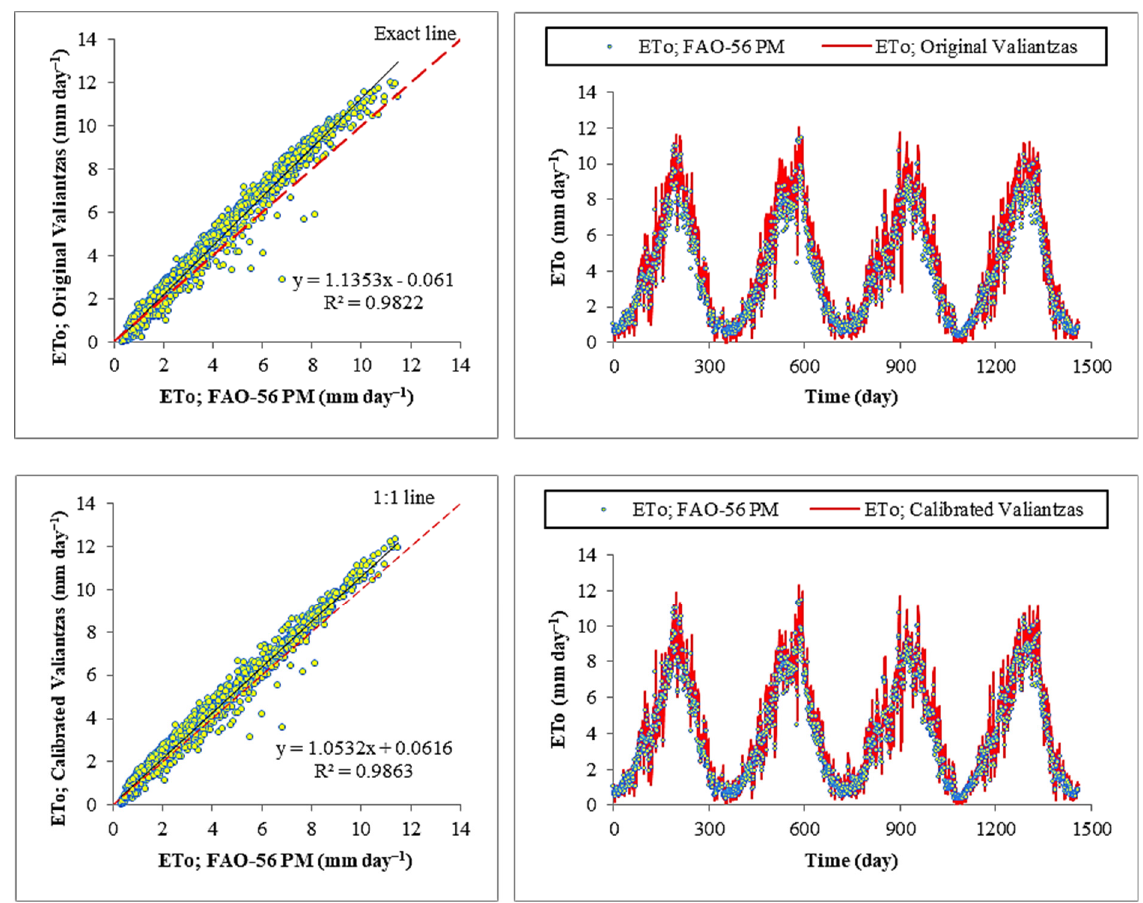
Figure 7. Scatter and time series plots of the daily values of FAO-56 PM ETo vs. modeled data by the original and calibrated forms of Valiantzas equation during the test phase (Tabriz station).